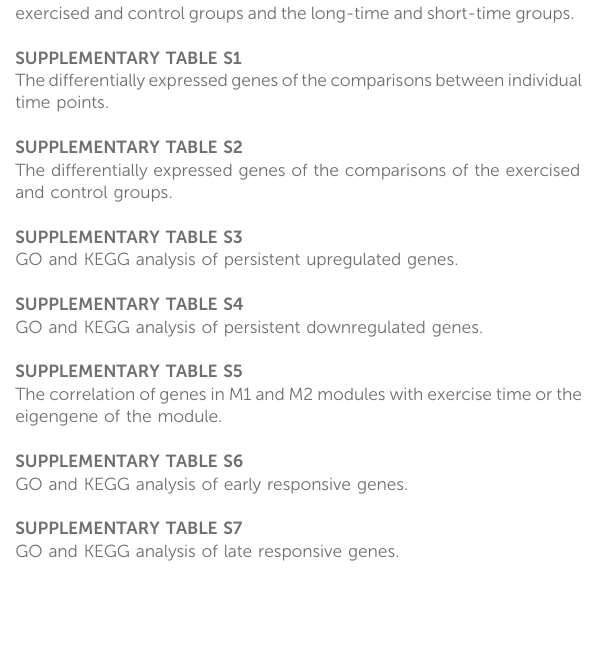
SUPPLEMENTARY TABLE S4 GO and KEGG analysis of persistent downregulated genes.